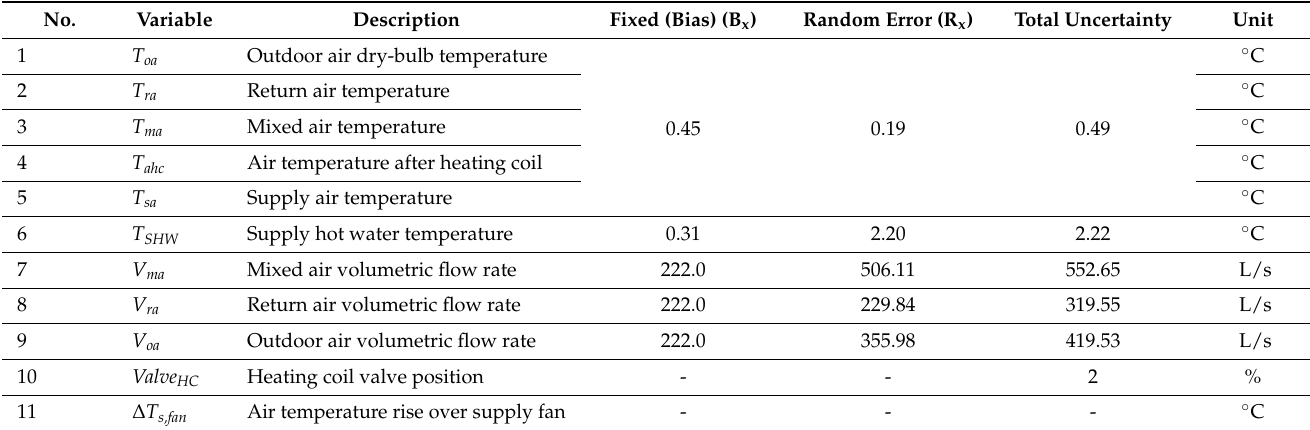
Table 2. List of AHU variables.